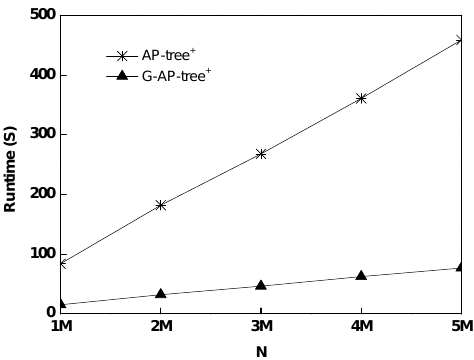
Figure 14. Evaluating the query performance of G-AP-tree +